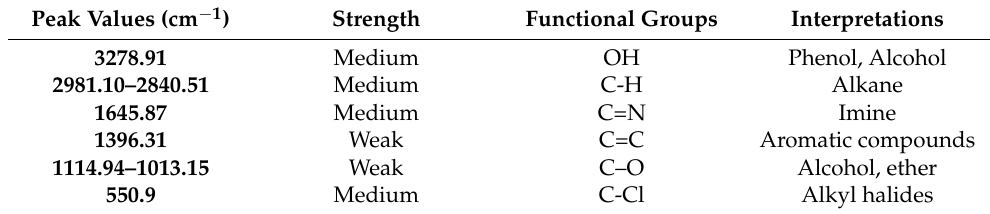
Table 1. FTIR analysis of leaf extracts of B. pachyncantha .